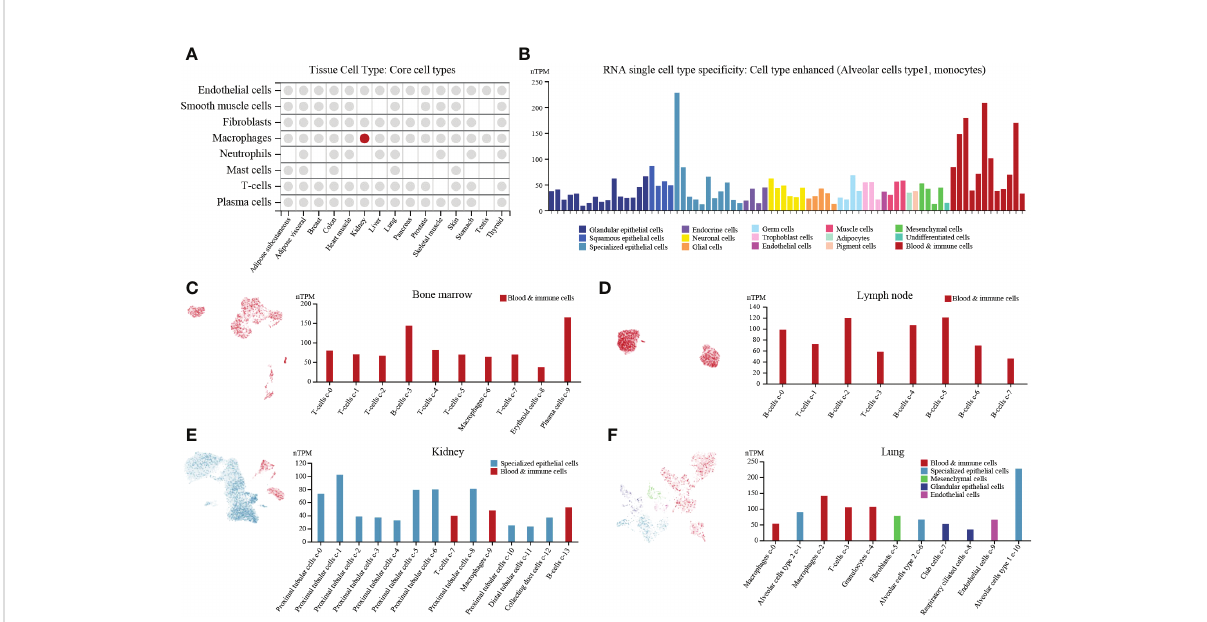
FIGURE 1 PTP1B expression in normal tissues/organs at single cell level. (A) PTP1B RNA expression in core cell types of some tissue cell types. (B) The cell type of PTP1B RNA single cell type speci fi city. The Alveolar cells type1 and monocytes showed enhanced. (C-F) PTP1B expression in all cells at single cell level. Single cell analysis of PTP1B expression in bone marrow (C) , lymph node (D) , kidney (E) and lung (F)